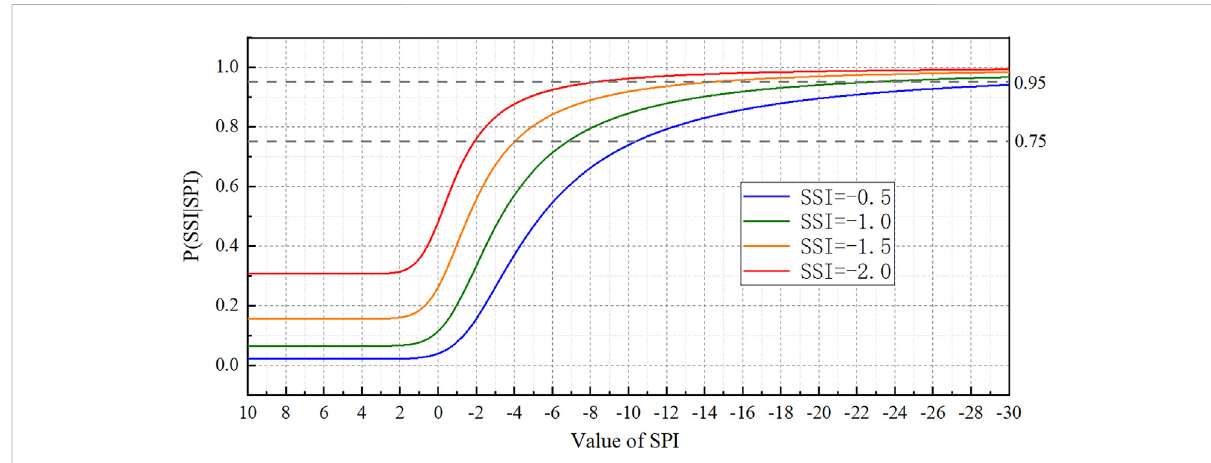
FIGURE 9 Probabilistic model of the relationship between meteorological and hydrological